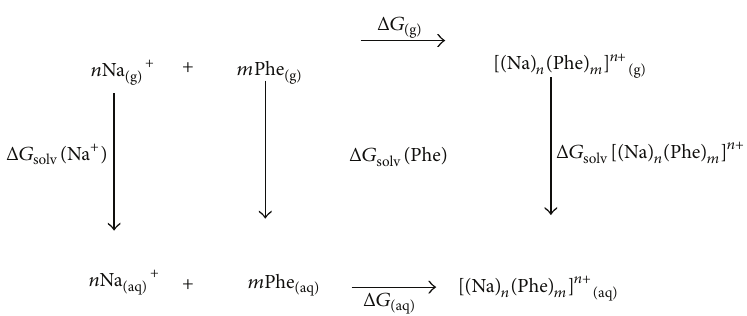
Figure 1: Thermodynamics cycle.